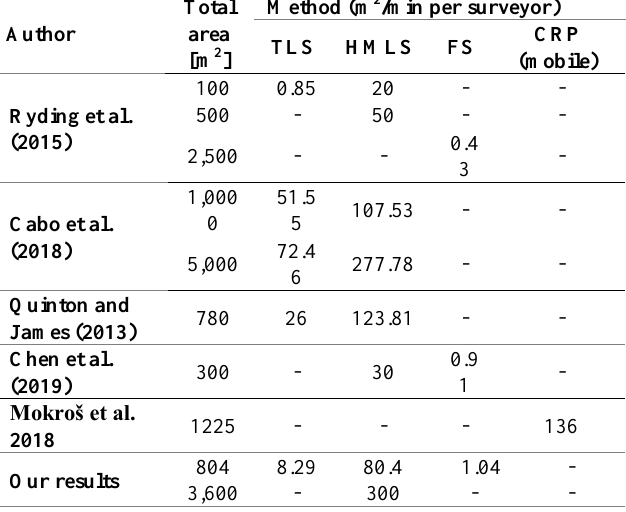
Table 6. Comparison of efficiency of different approaches for data